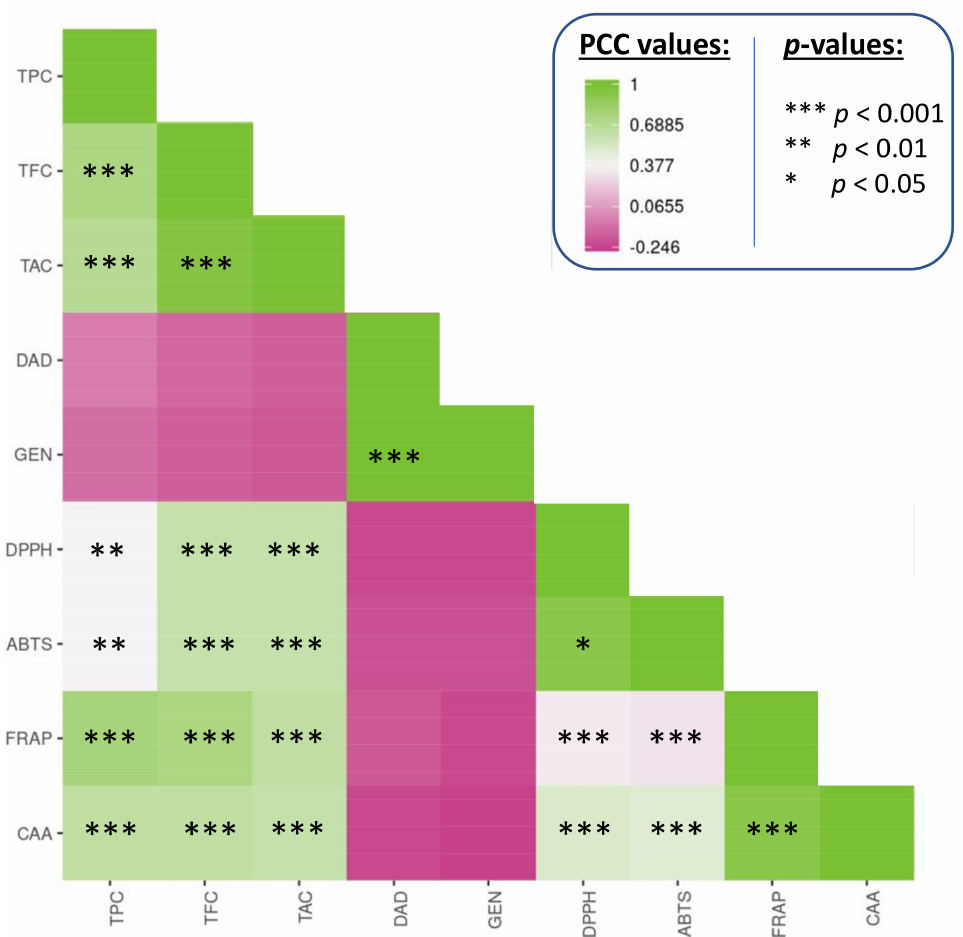
Figure 6. Correlogram analysis (Pearson coefficient correlation) between phytochemical profiles and antioxidant activities of extracts. *** significant p < 0.001; ** significant p < 0.01; * significant p < 0.05; PCC values are indicated in Table